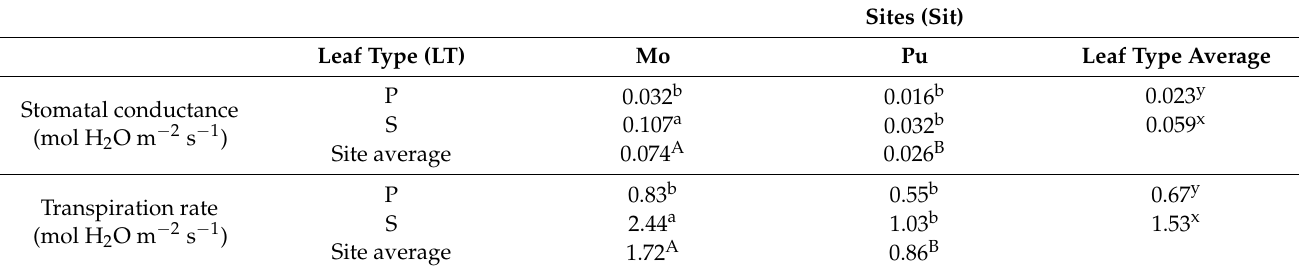
Table 3. Leaf-level stomatal conductance and transpiration rate of different leaf types (P: petiolate; S: sessile) of Salvia ceratophylloides individuals of two sites (Mosorrofa, Mo; Puzzi, Pu) measured at a light intensity of 800 µ mol m − 2 s − 1 . Different lower-case letters represent significant differences at p < 0.05 among the average within the column (Tukey’s test). Different capital case letters represent statistically significant differences among the means along the rows ( p < 0.05, Tukey’s test).